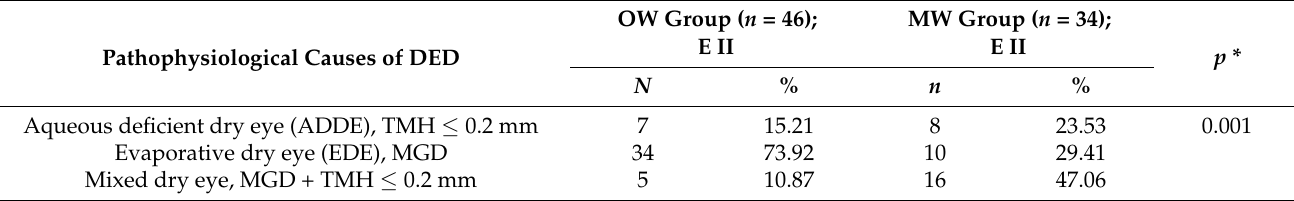
Table 8. Pathophysiological causes of dry eye disease in the OW and MW groups at the 1-year follow-up.